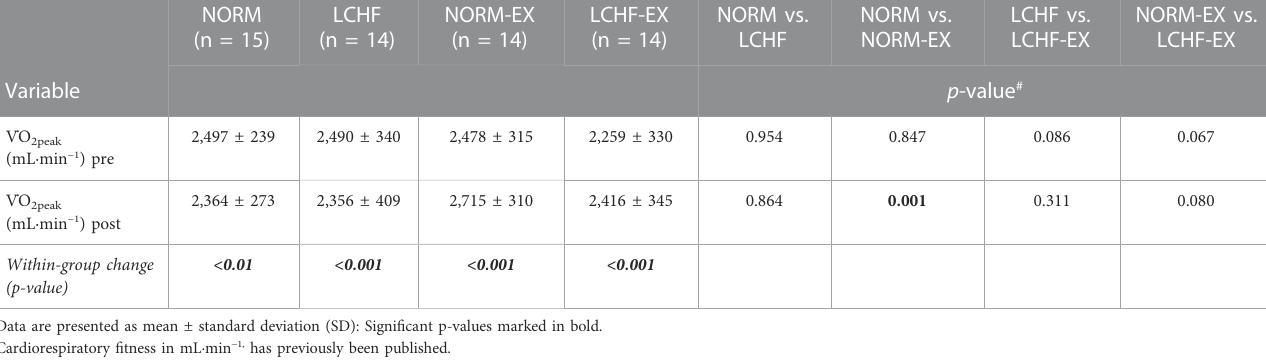
TABLE 2 Ancillary analysis: Cardiorespiratory fi tness at baseline and after the 10-week intervention.